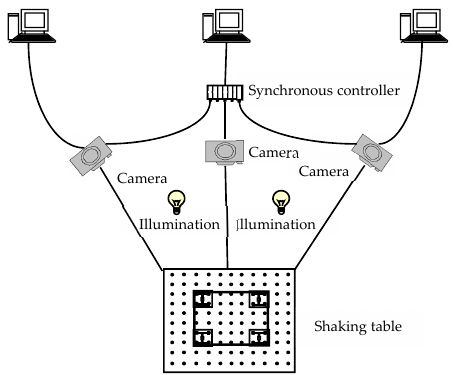
Figure 2. The configuration of tri-camera videogrammetric measurement system.